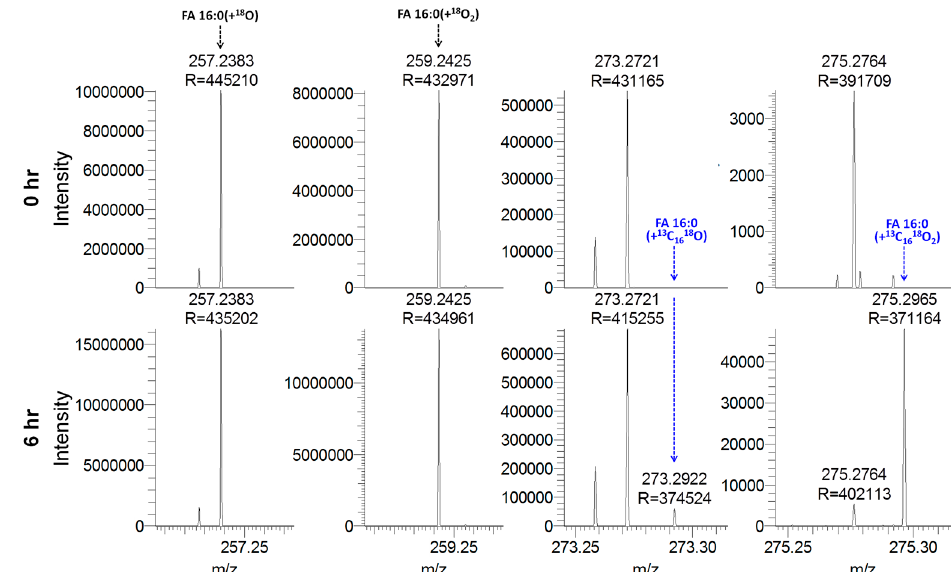
Figure 6. Specific monitoring of fatty acyl (FA) 16:0(+ 13 C 16 ) in human plasma by high resolution Fourier transform mass spectrometry (FTMS). Representative FTMS spectra of plasma from a normoinsulinemic subject at 0 h (baseline) and 6 h after intake of FA 16:0(+ 13 C 16 ). Plasma samples were subjected to acid-catalyzed hydrolysis with H 218 O and analyzed by high resolution FTMS analysis. Indicated FA analytes are detected as deprotonated carboxylate anions.